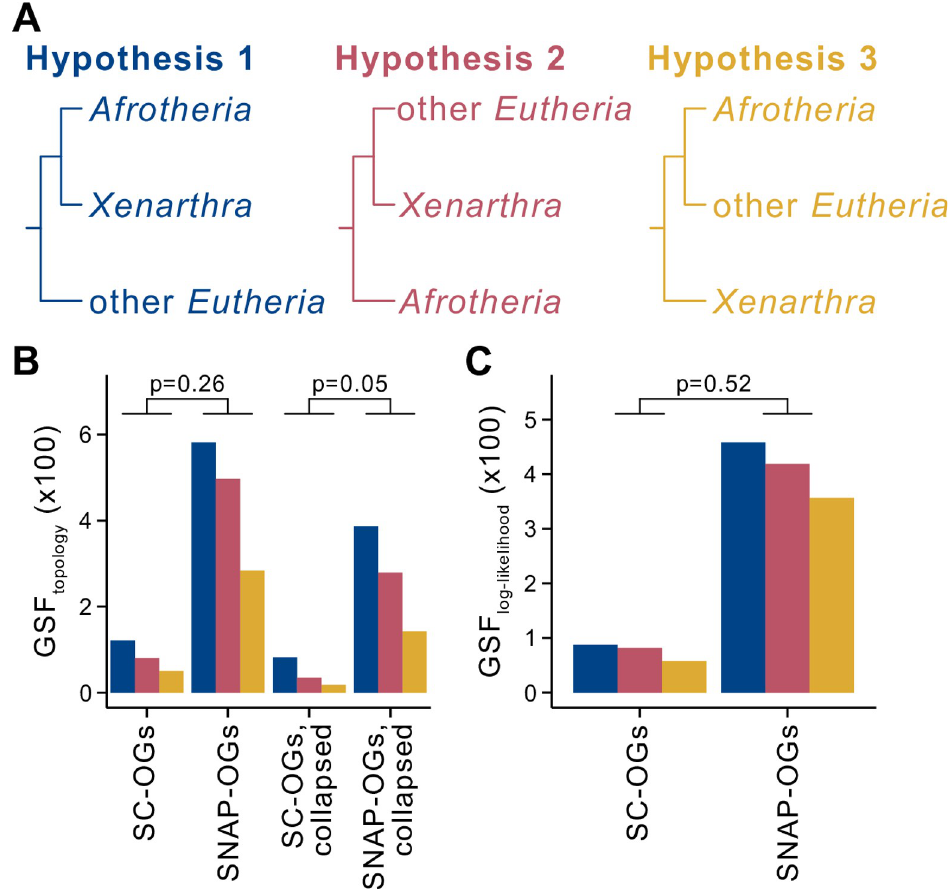
Fig 4. SC-OGs and SNAP-OGs display similar patterns of support in a contentious branch concerning deep evolutionary relationships among eutherian mammals. ( A ) Two leading hypotheses for the evolutionary relationships among Eutheria, which have implications for the evolution and biogeography of the clade, are that Afrotheria and Xenarthra are sister to all other Eutheria (hypothesis 1; blue) and that Afrotheria are sister to all other Eutheria (hypothesis 2; pink). The third possible, but less well-supported topology, is that Xenarthra are sister to Eutheria and Afrotheria. ( B ) Comparison of gene support frequency (GSF) values for the 3 hypotheses among 252 SC-OGs and 1,428 SNAP-OGs using an α level of 0.01 revealed no differences in support ( p = 0.26, Fisher’s exact test with Benjamini–Hochberg multitest correction). Comparison after accounting for gene tree uncertainty by collapsing bipartitions with ultrafast bootstrap approximation support lower than 75 (SC-OGs collapsed vs. SNAP-OGs collapsed) also revealed no differences ( p = 0.05; Fisher’s exact test with Benjamini–Hochberg multitest correction). ( C ) Examination of the distribution of frequency of topology support using gene-wise log-likelihood scores revealed no difference between SNAP-OGs and SC-OGs support for the 3 topologies ( p = 0.52; Fisher’s exact test). The data underlying this figure can be found in figshare (doi: